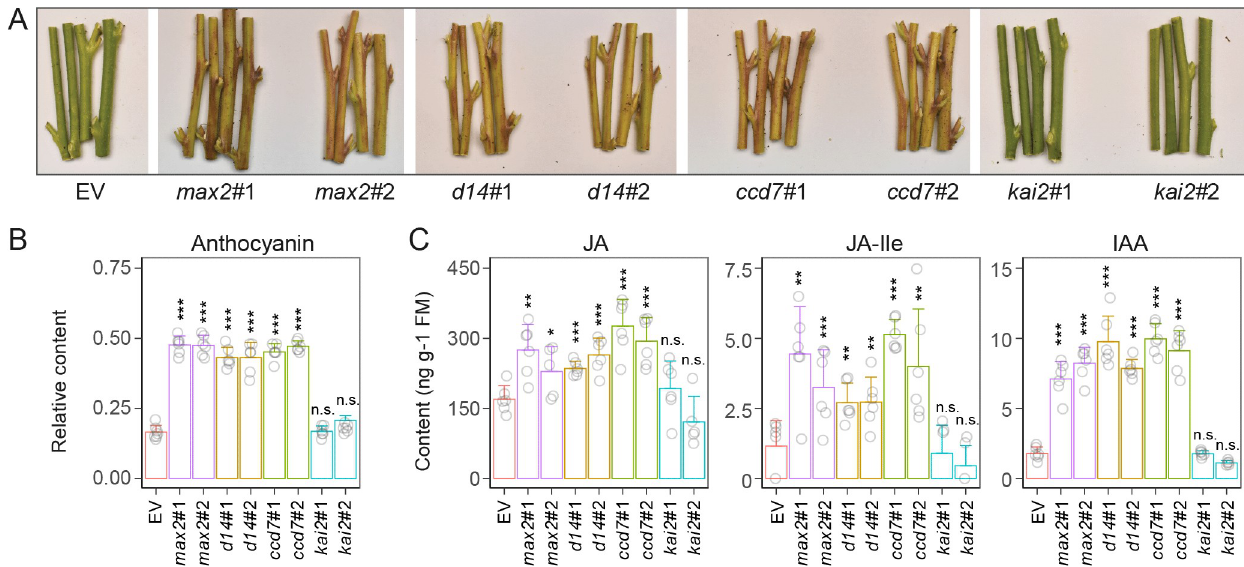
Fig 2. Anthocyanin accumulations in stems of max2 , d14 , ccd7 , and kai2 plants. (A) Representative stem phenotypes of 75-day-old EV, max2 , d14 , ccd7 , and kai2 plants. (B) Relative anthocyanin levels in epidermis of stems of indicated plants ( ± SE, n = 8). (C) Levels of JA, JA-Ile, and IAA in stems of indicated plants ( ± SE, n = 6) ( � P < 0.05; �� P < 0.01; ��� P < 0.001; two-tailed Student t test). Values for graphs (B) and (C) are listed in S1 Data. ccd, carotenoid cleavage dioxygenase; d14, dwarf 14; EV, empty vector; IAA, indole-3-acetic acid; JA, jasmonate; JA-Ile, jasmonic acid-isoleucine; kai2, karrikin insensitive 2; max2, more axillary growth 2; n.s. not